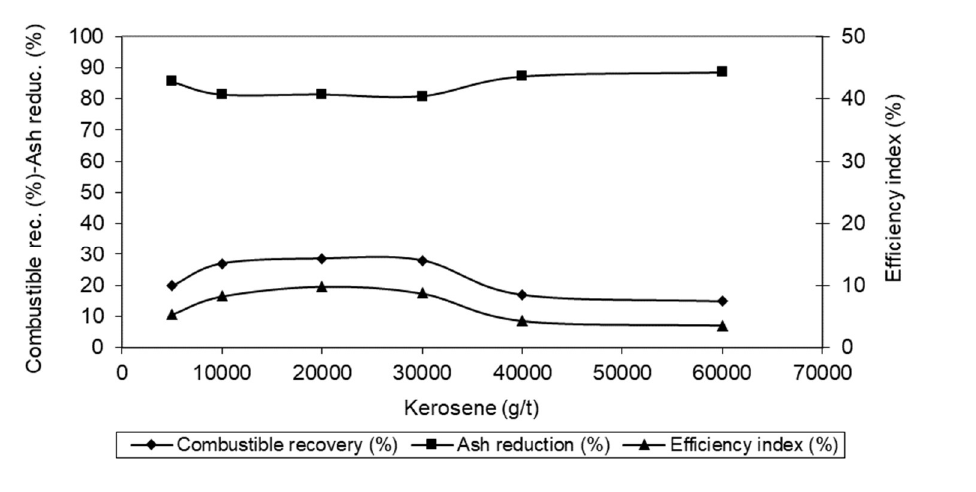
Fig.2 . Effect of kerosene concentration on combustible recovery, ash reduction and efficiency index